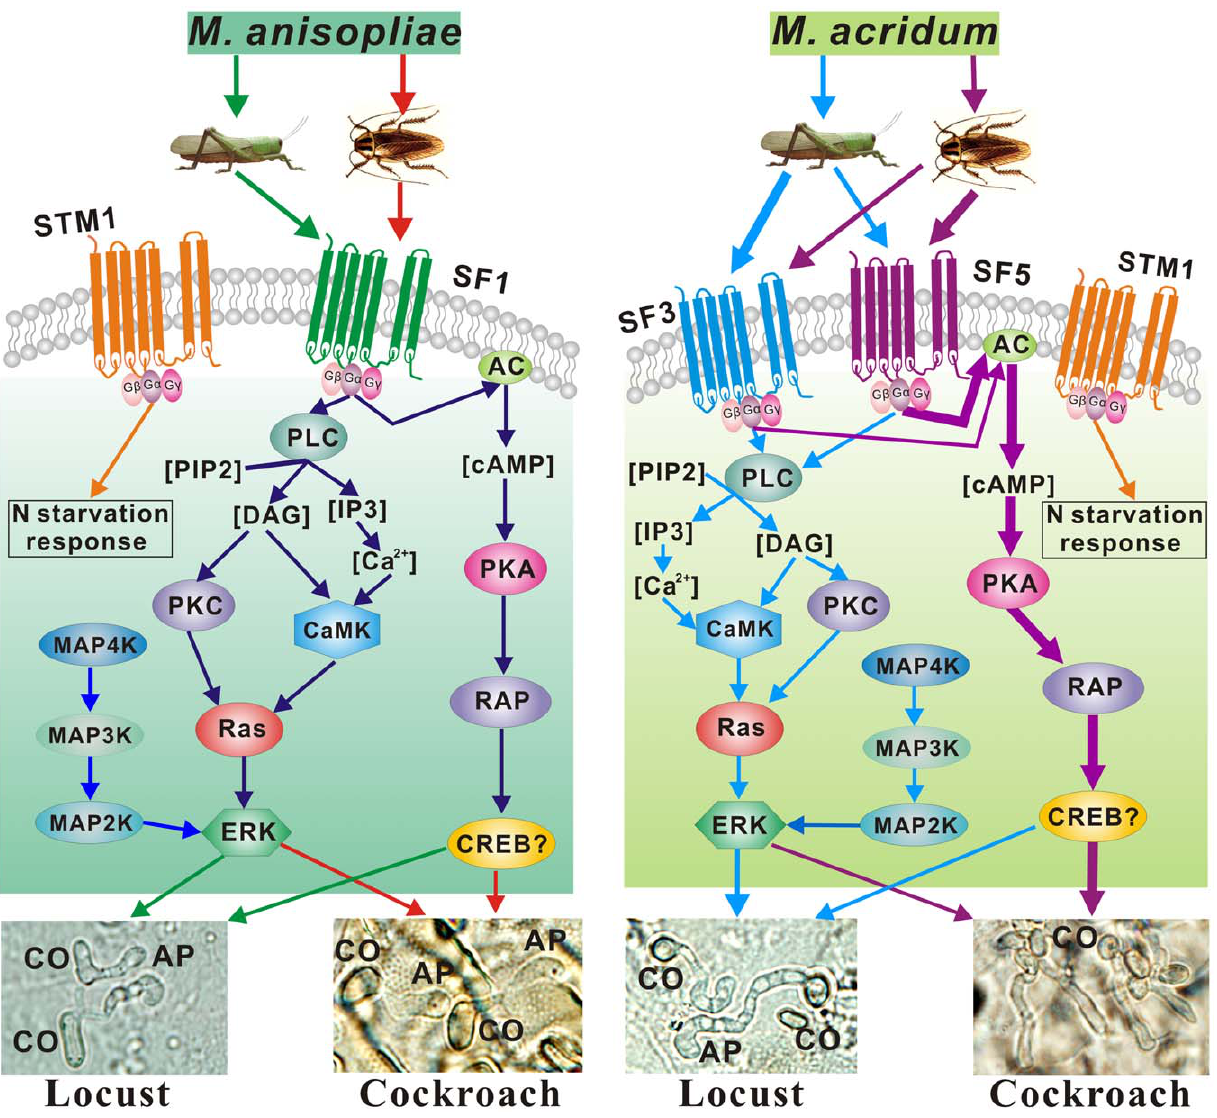
Figure 7. Differentially regulated signaling pathways employed by M.anisopliae and M.acridum infecting cockroach and locust cuticles. Both the MAP kinase and cAMP dependent protein kinase A (PKA) pathways were activated by M. anisopliae and M. acridum infecting cockroach and locust cuticles. PLC, phosphatidyl inositol-specific phospholipase C; PIP2, phosphatidylinositol 4,5-bisphosphate; IP3, inositol 1,4,5- triphosphate; DAG, diacylglycerol; PKC, protein kinase C; CaMK, calcium/calmodulin regulated kinase; ERK, extracellular signal-regulated protein kinase; CREB, a basic leucine zipper transcription factor that is a potential cAMP response element-binding protein; CO, conidium; AP, appressorium. Thicker arrows indicate pathways that are more highly expressed by M. acridum on either locust or cockroach